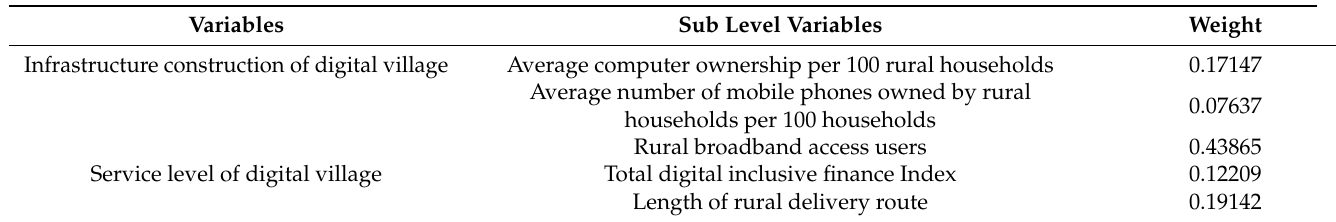
Table 2. Digital rural construction level evaluation index system.